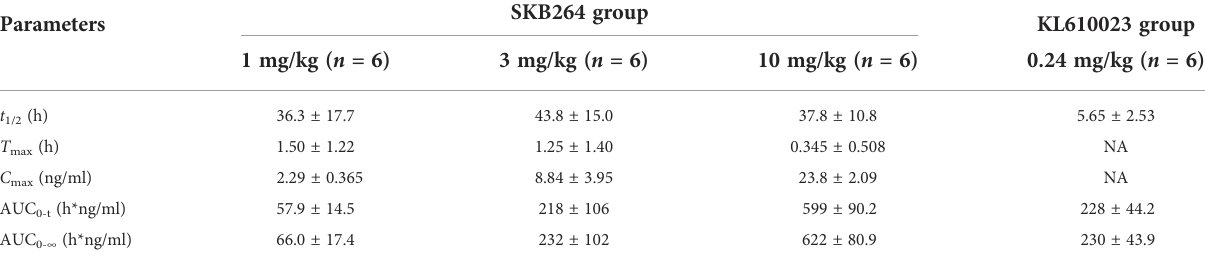
TABLE 3 Serum pharmacokinetic parameters of the payload after administration of SKB264 and KL610023 in cynomolgus monkeys (mean ± SD). Parameters